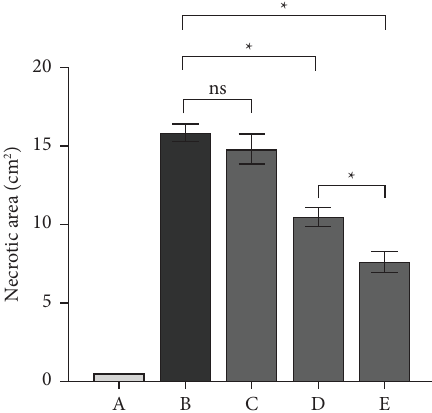
Figure 2: Necrotic area in diferent groups. Te necrotic areas are represented with mean and SEM. Tere was no signifcant dif- ference between the B and C groups, p > 0 . 05. Te necrotic areas of the D and E groups were less than those of the model group, with the E group having the smallest area, p < 0 . 05. Te unit of necrotic area is square centimeter (cm 2